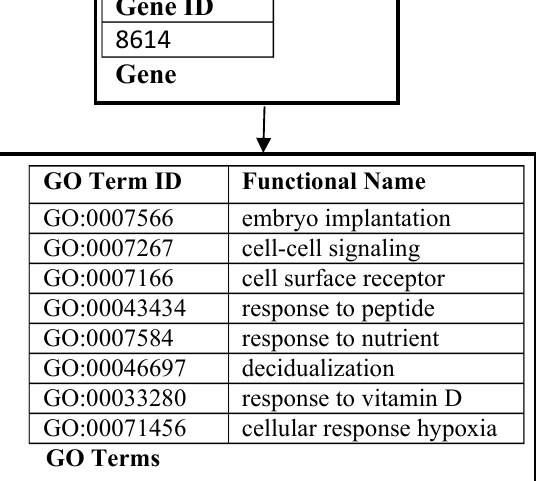
Figure 3. Gene association with the GO